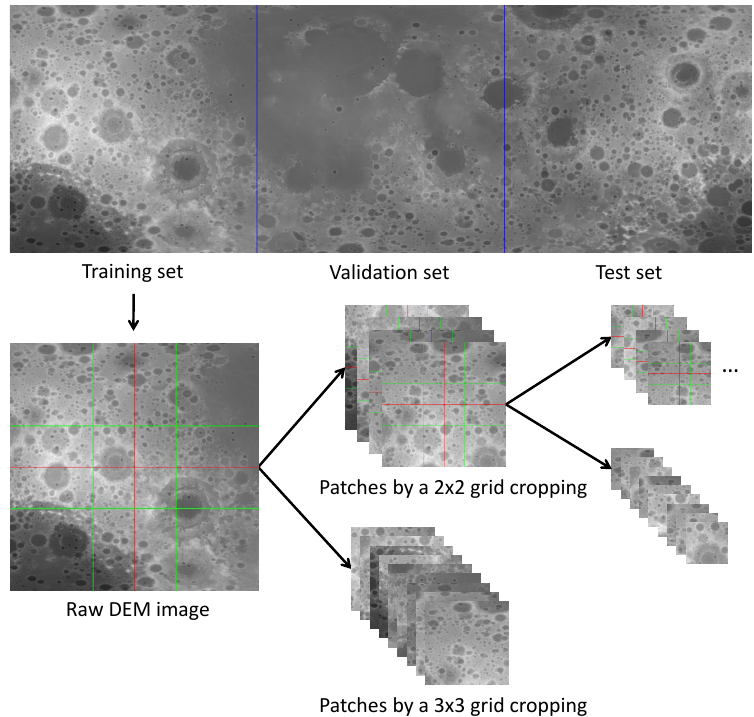
Figure 2. A multi-scale grid cropping strategy applied to the lunar DEM